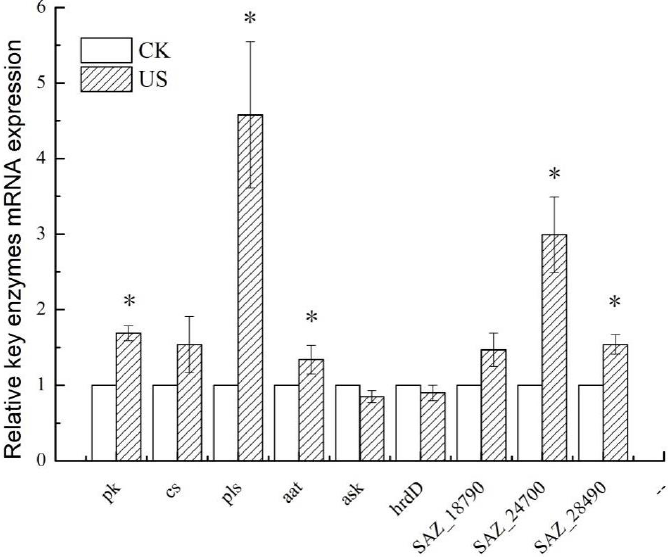
Figure 7. mRNA relative transcription levels of important genes for ε -polylysine biosynthesis (* p < 0.05).